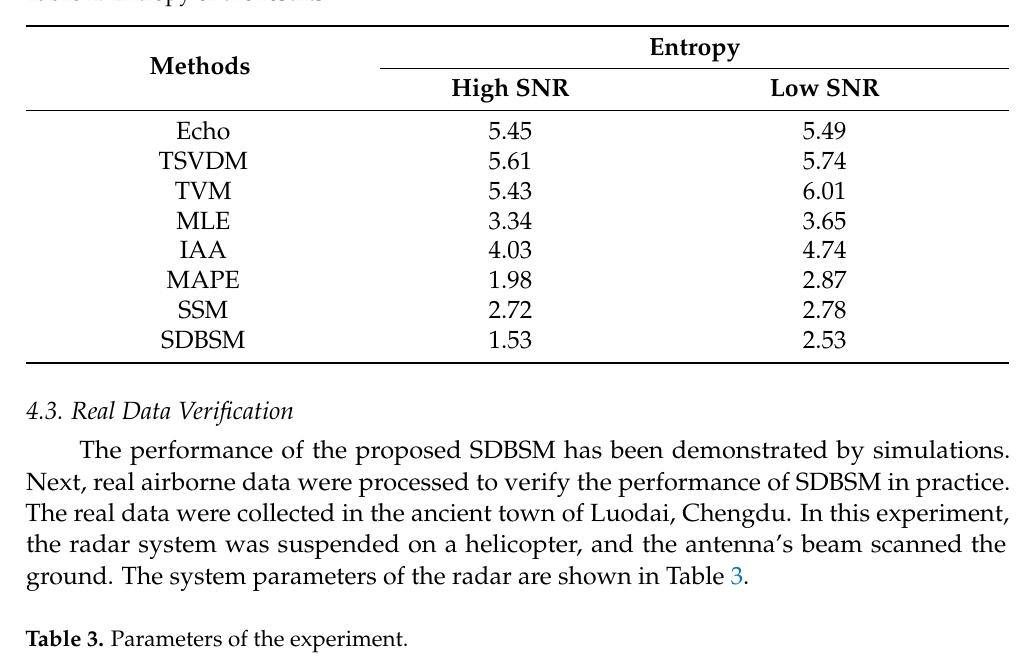
Table 2. Entropy of the results.